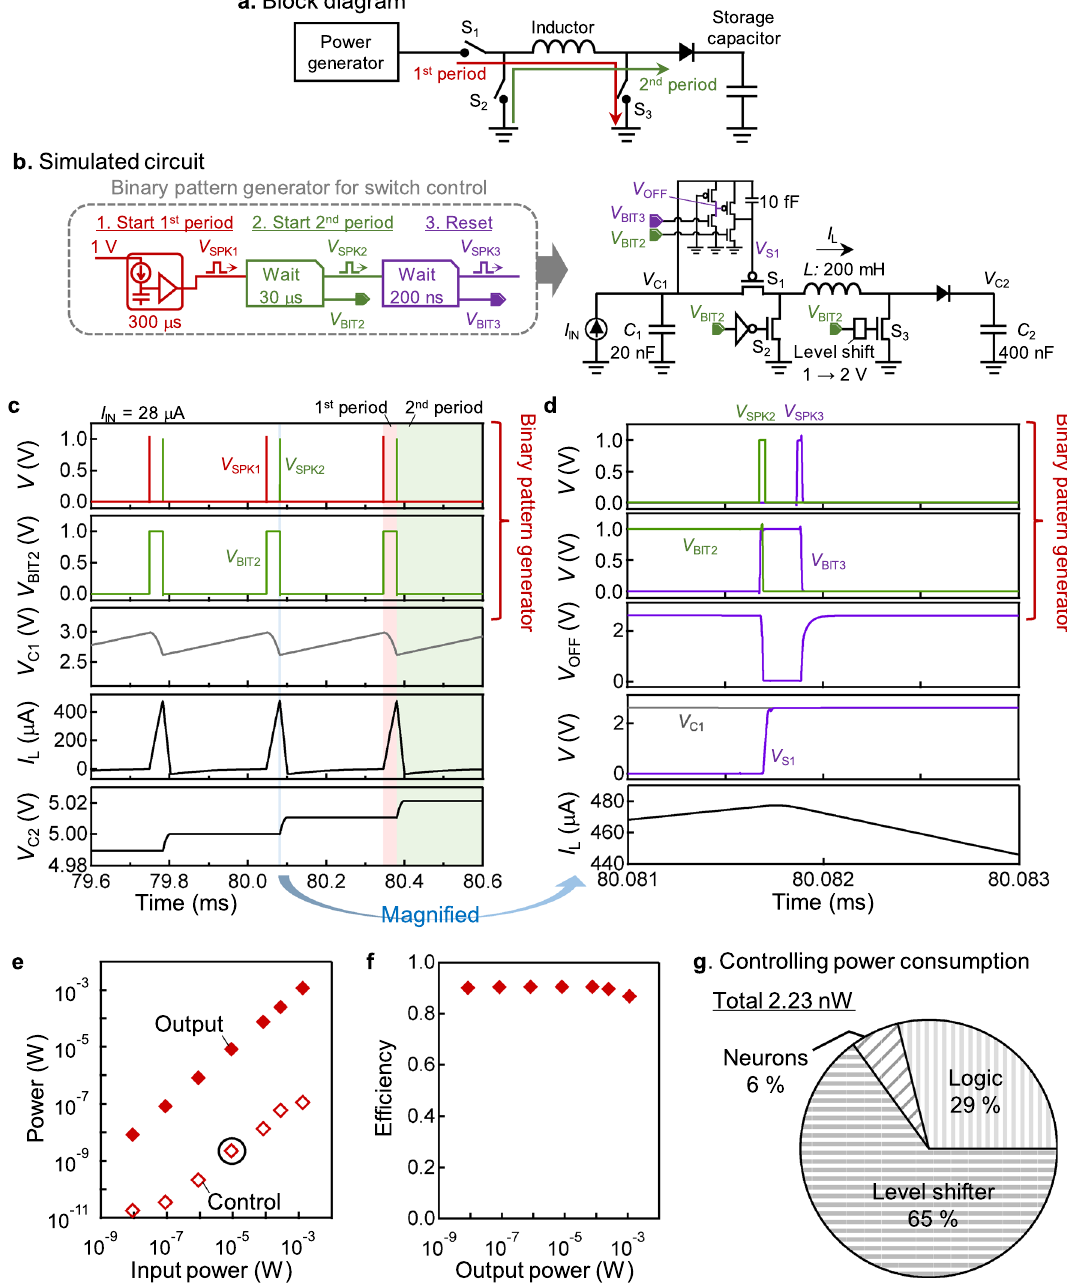
Figure 2. Application example of the binary pattern generator. ( a ) A block diagram of the DC-DC voltage converter circuit that consists of an inductor and several switches. ( b ) A circuit diagram of the simulated DC-DC voltage converter circuit, where the switching operation is controlled by the binary pattern generator. The binary pattern generator consists of a spiking neuron circuit defining the switching period, and two waiting time generators for switching sequences. The topology of the DC-DC voltage converter circuit is a typical buck- boost converter with a 200 mH inductor. ( c ) The voltage or current wave forms of the binary pattern generator and the DC-DC voltage converter circuit. ( d ) The wave forms of the binary pattern generator and the voltages around the S 1 switch. The time span corresponds to the blue shadowed region in (c). ( e ) The simulated output power and the control power as a function of the input power when V C1 is around 3 V and V C2 is around 5 V. The input power is varied by changing the period of V SPK1 from 3 s to 50 μs. The control power is negligible, several orders smaller than the input or output power. ( f ) The simulated power conversion efficiency (the ratio of the output power to the input power) as a function of the output power, which remains a relatively high value down to an extremely low output power level. ( g ) The classification of the control power (2.23 nW) when the input power is 84 μW, which corresponds to a point with a solid circle in ( e ). The power consumption of the binary pattern generator (“Neurons”) is sufficiently small, even smaller than the logic